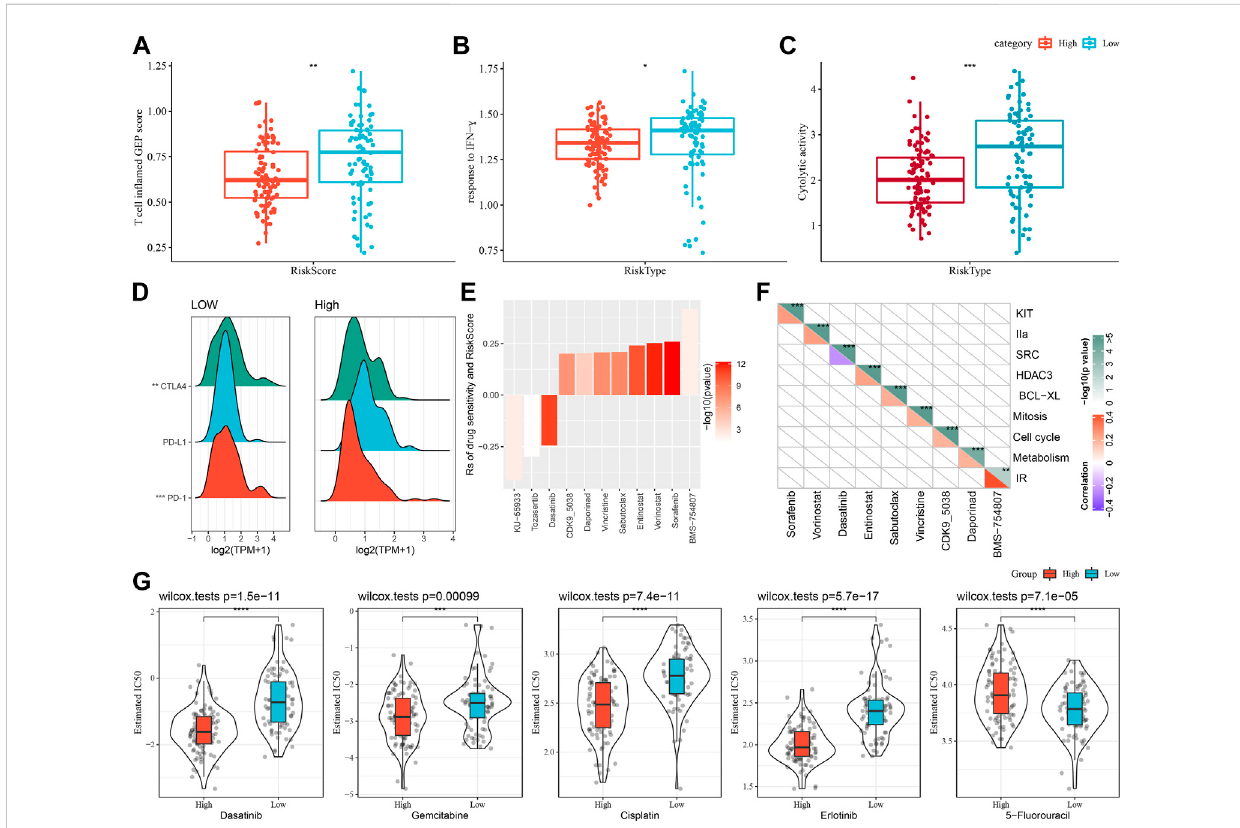
FIGURE 8 Theprognosticriskmodelsinpredictingpatients ’ bene fi tfromimmunization/chemotherapy. (A) Differencesin “ Tcellin fl amedGEPscore ” between subgroups; (B) Differences in “ response to IFN- γ ” between subgroups; (C) Differences in “ C- γ ” between subgroups. (C) Difference of “ Cytolytic activity ” betweendifferentsubgroups; (D) Differenceofimmunecheckpointgeneexpressionbetweendifferentsubgroups; (E) Spearmananalysiswasconducted for correlation analysis on drug sensitivity andRiskScore,with eachcolumnrepresenting atype ofdrug.Correlation signi fi cance isre fl ected incolor brightness. The correlationofRiskScore withdrug sensitivity(Rs < 0) ordrug resistance (Rs > 0)wasre fl ected intheheight ofacolumn. (F) Thehorizontal axis is the drug name and the vertical axis is the signaling pathway targeted by the drug. The signaling pathway targeted by the drug is sensitive to RiskScore (blue); (G) Box plots of IC50 estimates for dasatinib, gemcitabine, cisplatin, erlotinib and 5- fl uorouracil in TCGA-PAAD; * p < 0.05; ** p < 0.01; *** p < 0.001; and **** p <